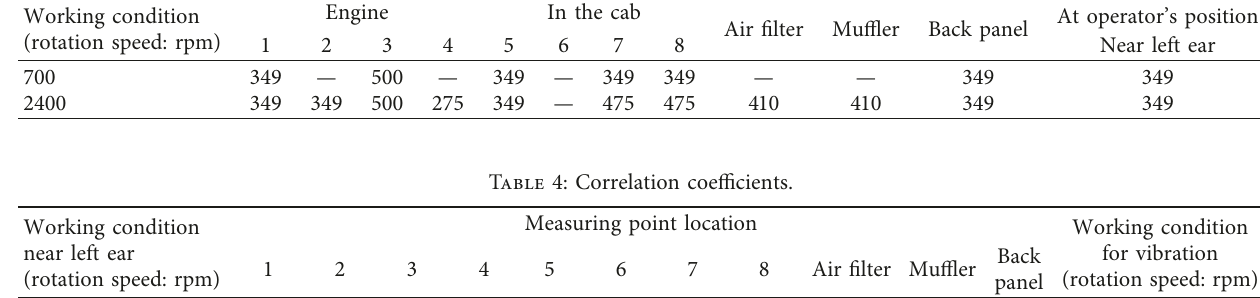
Table 3: Peak frequency (Hz).